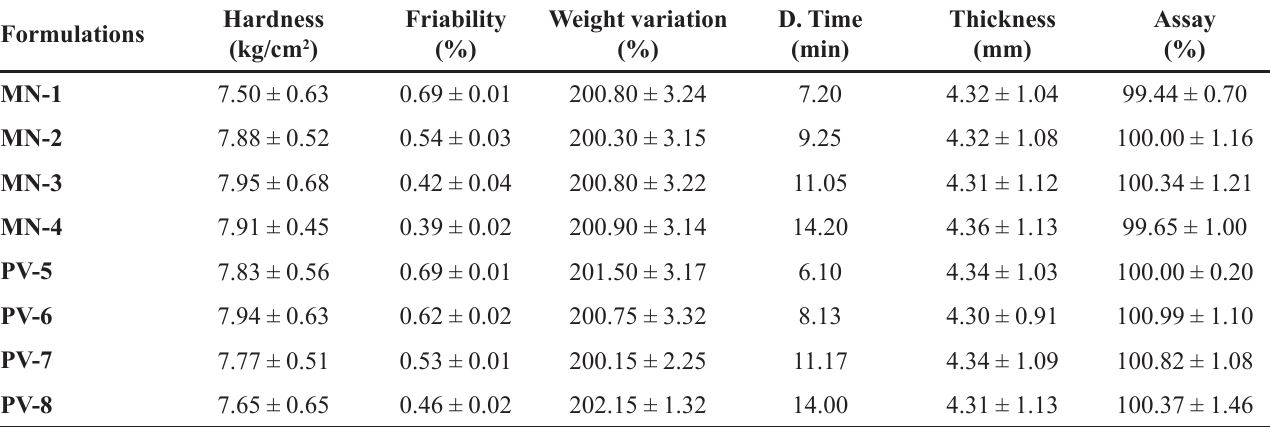
TABLE V - Evaluation of diclofenac sodium tablets Formulations